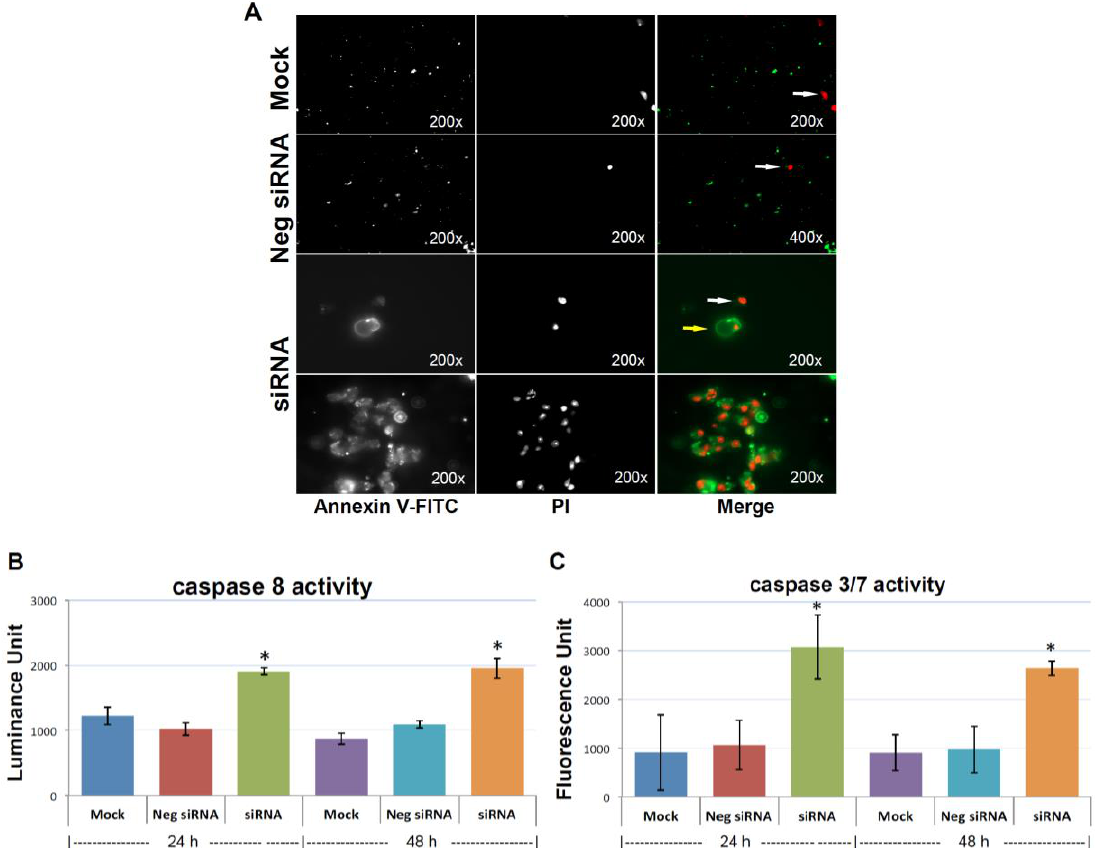
Figure 5. Knocking-down KIAA0100 induces anoikis. ( A ) Annexin V staining: anoikis of the cell in suspension were assessed by Annexin V-FITC apoptosis assay. Most of the mock control and negative siRNA transfected cells show no visible signal of Annexin V-FITC other than sporadic death cell stained with propidium iodide (PI) (white arrow). Two types of staining pattern for Anoikis were shown for cells transfected with KIAA0100 siRNA: early stage of Anoikis—cells that have lost membrane integrity will show red PI staining throughout the nuclei and a ring-like green staining Annexin V-FITC on the plasma membrane; late stage of Anoikis—cells stained with PI for the nuclei without Annexin V staining with or without halo-green like Annexin V-FITC staining. Apoptosis/Anoikis activation was examined by Caspase 8, 3/7 activity assay: ( B ) caspase 8 activity significantly increased in cells treated with KIAA0100 siRNA in both 24 and 48 h after transfection compared to mock control cells and cells treated with negative siRNA (*, p < 0.05); ( C ) caspase 3/7 activities in cells treated with KIAA0100 siRNA were significantly higher compared to mock control cells and cells treated with negative siRNA (*, p < 0.05).